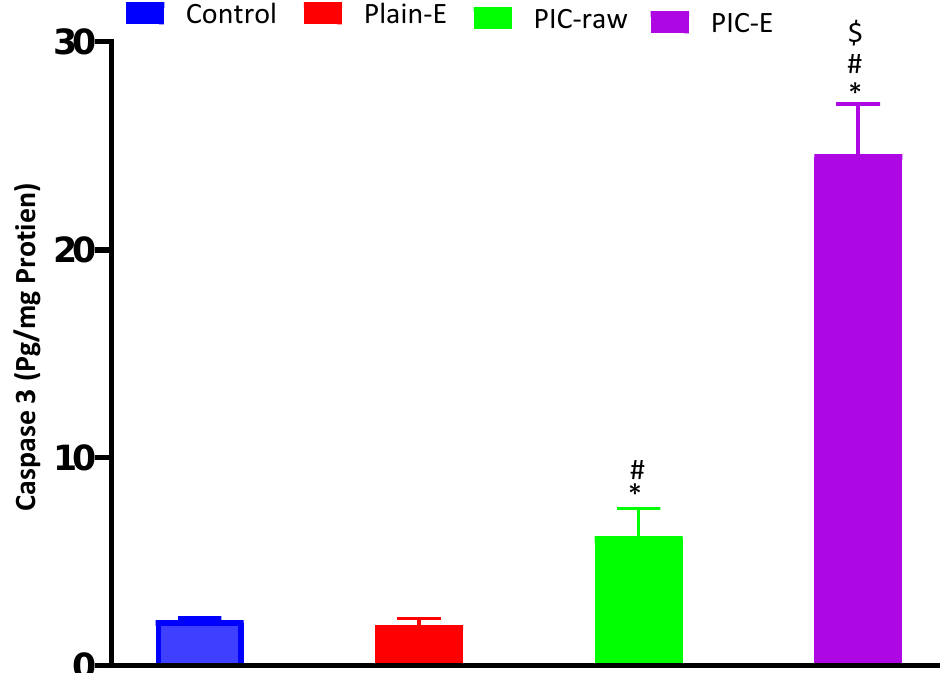
Figure 8. Effect of PIC-E on MMP in HCT 116 cells. Cells were incubated for 24 h with plain-E, PIC-raw (0.1 µM), or PIC-E (equivalent to 0.1 µM PIC) * Significantly different from control at p < 0.05. # Significantly different from plain-E at p < 0.05. $ Significantly different from PIC-raw at p < 0.05.